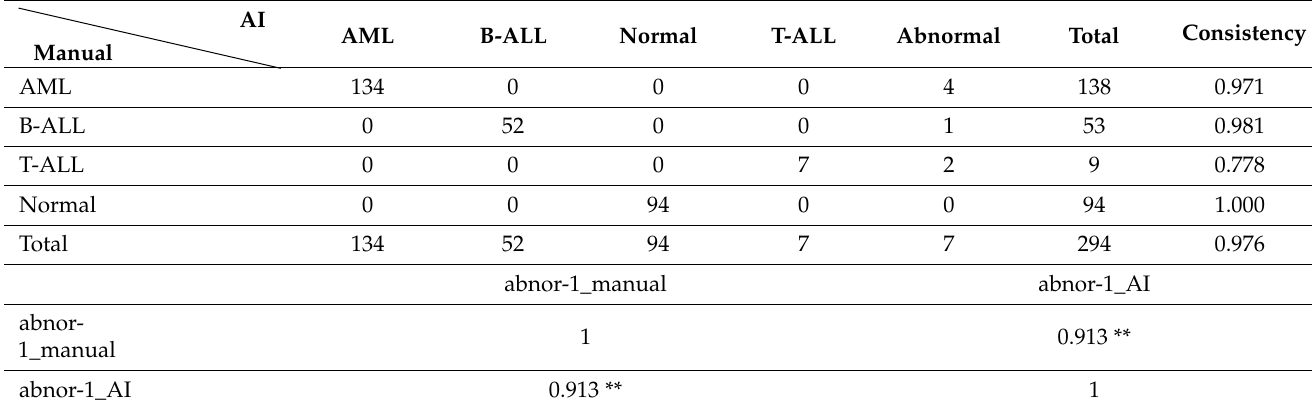
Table 1. Comparison of diagnostic results.